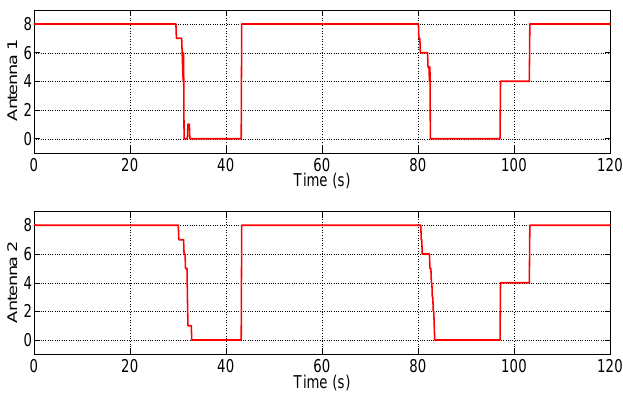
Figure 14. Number of captured satellites by the GPS